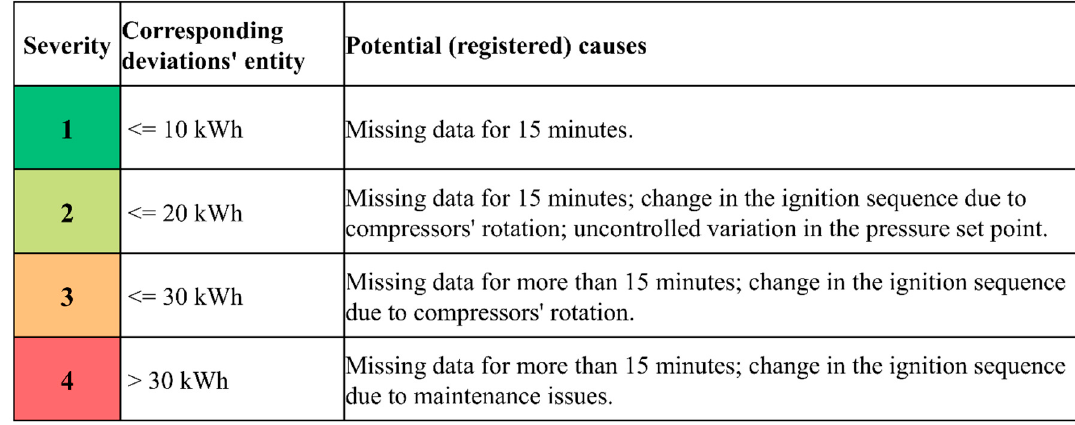
Figure 11. Classification of anomalies created on the basis of the anomalies’ registry.